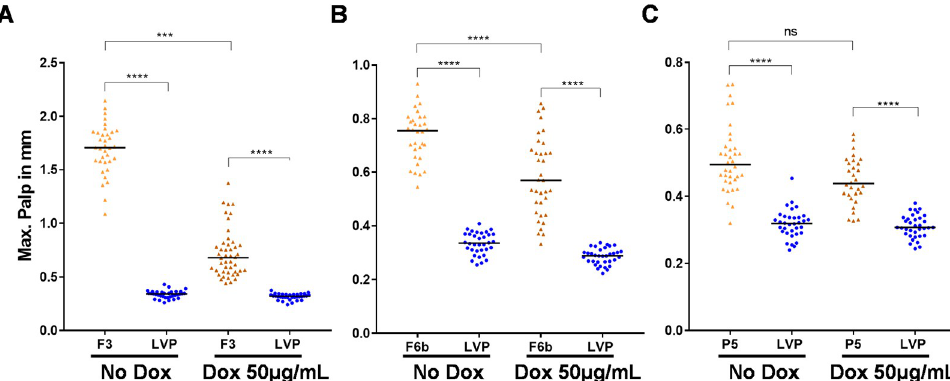
Fig 6. Doxycycline treatment partially restores maxillary palps size in transgenic females. Mosquitoes were reared in the absence or presence of 50ug/mL doxycycline and supplemented with SURE cells during larval and pupal stages and after emergence, adult pictures were taken and maxillary palps were measured from F3 ( A ), F6b ( B ) and P5 ( C ) transgenic lines and Liverpool strain. The bars from the maxillary palps measurements represent the median. A Mann– Whitney U test was used to evaluate statistical significance. ns: P > 0.05; ��� : P < 0.0001.